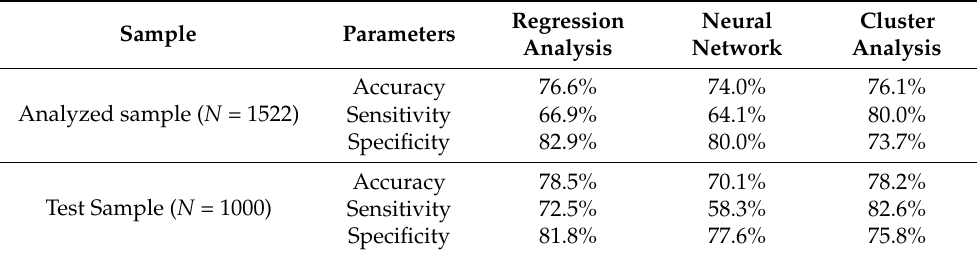
Table 3. Accuracy, sensitivity, and specificity percentages of the three applied analyses for the analyzed and tested